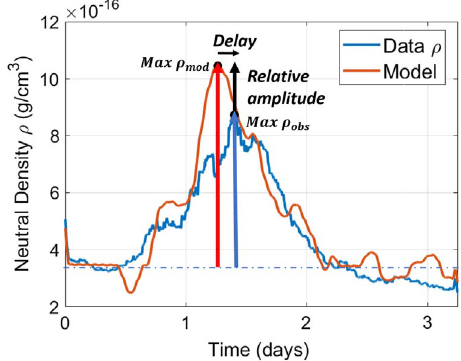
Fig. 3. Metrics of the storm peak amplitude and timing assessment. The model density is